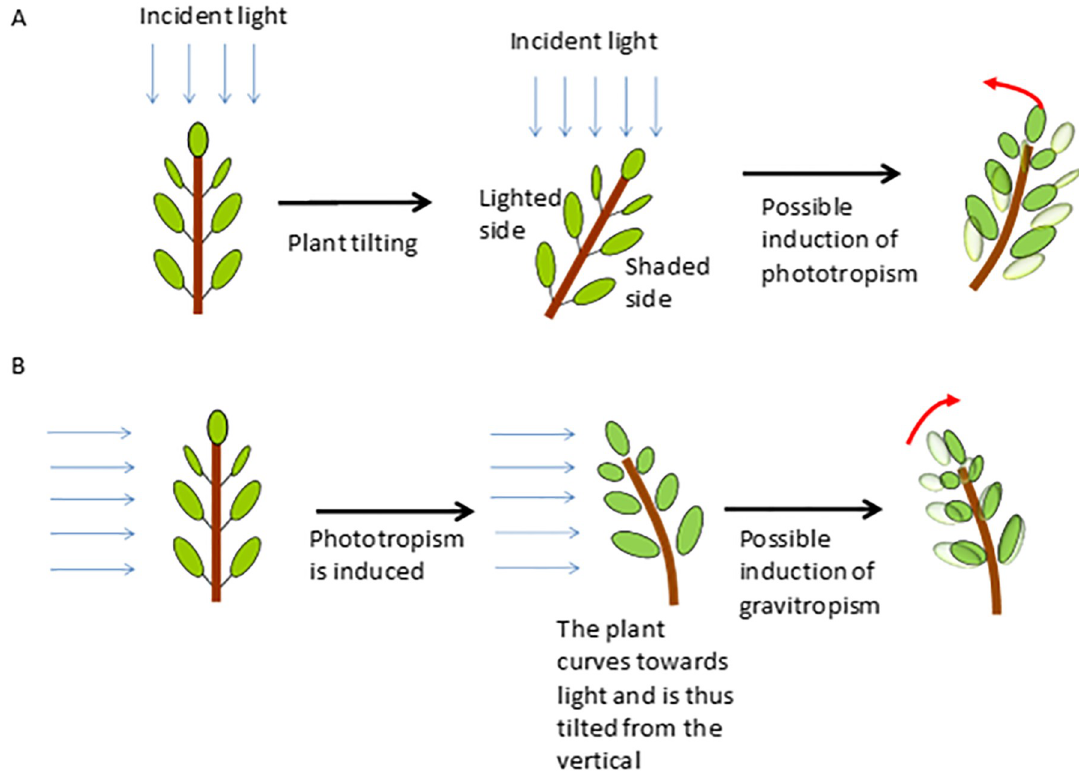
Fig 1. Diagram explaining the interactions between gravitropism and phototropism in classical experiments dedicated to the study of gravitropism and phototropism. A: In classical experiments, a plant is tilted from the vertical in order to study gravitropism. In this case, since the light is coming from the top, one side of the stem is shaded, which can induce a phototropic reaction. B: In classical experiments, a plant is lit unilaterally in order to study phototropism. Since the plant bends towards the unilateral light, the stem is curved and thus tilted, which can induce a possible counteractive movement due to